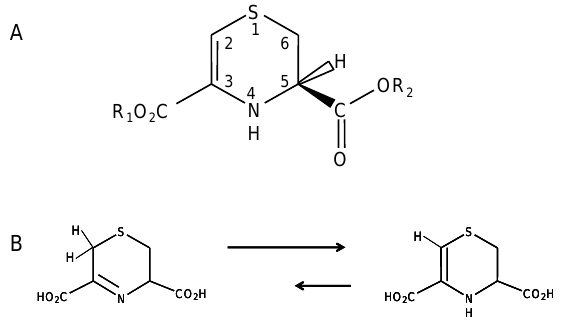
= R = H. B: Tautomerism 1 2